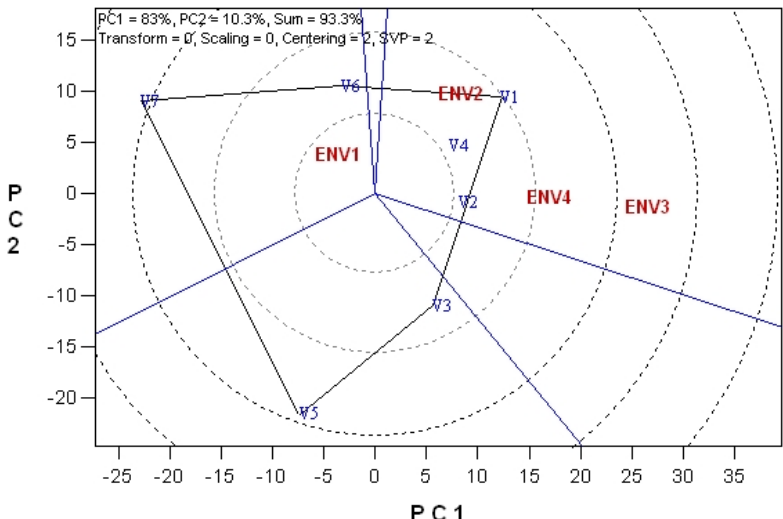
Fig. 4. GGE biplot analysis; V1-‘Pleven 6’, V2-‘Prista 2’, V3-‘Multifoliate’, V4-alfalfa local population LP1, V5-alfalfa local population LP2, V6-local population of birdsfoot trefoil, V7-local population of red